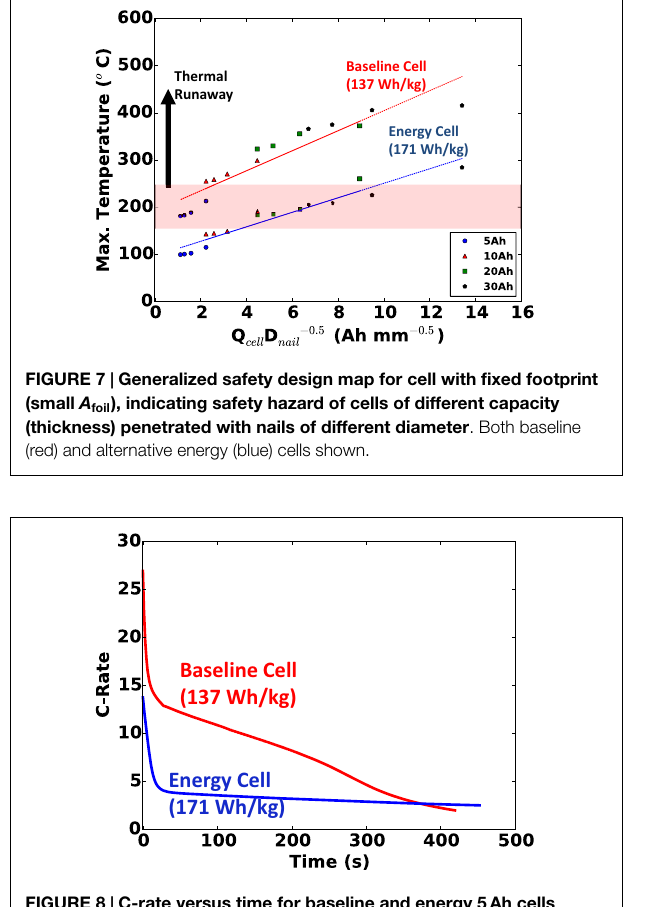
FIGURE 8 | C-rate versus time for baseline and energy 5Ah cells shorted with 20mm diameter nail . Nail penetration occurs at t =